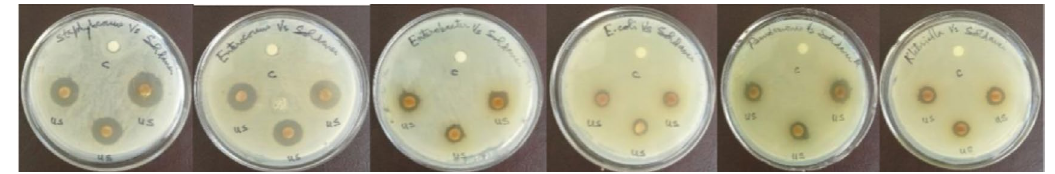
Fig. 2. Plates of Disc diffusion assay showing antibacterial activity of G. pedunculata ethanol extract on UTI clinical bacterial isolates.(C=Control disc impregnated with ethanol; US=Disc impregnated with EEGP).